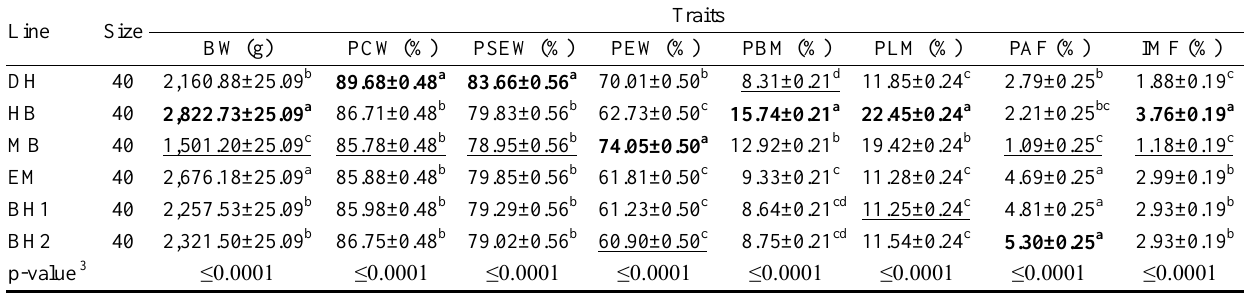
Table 2. Population effects on carcass traits and IMF in chickens